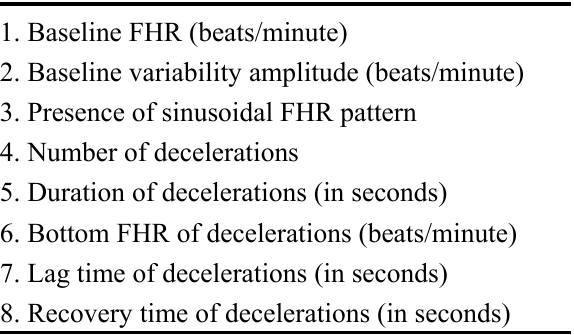
Table 1. The 8 FHR Parameters Used in NNW